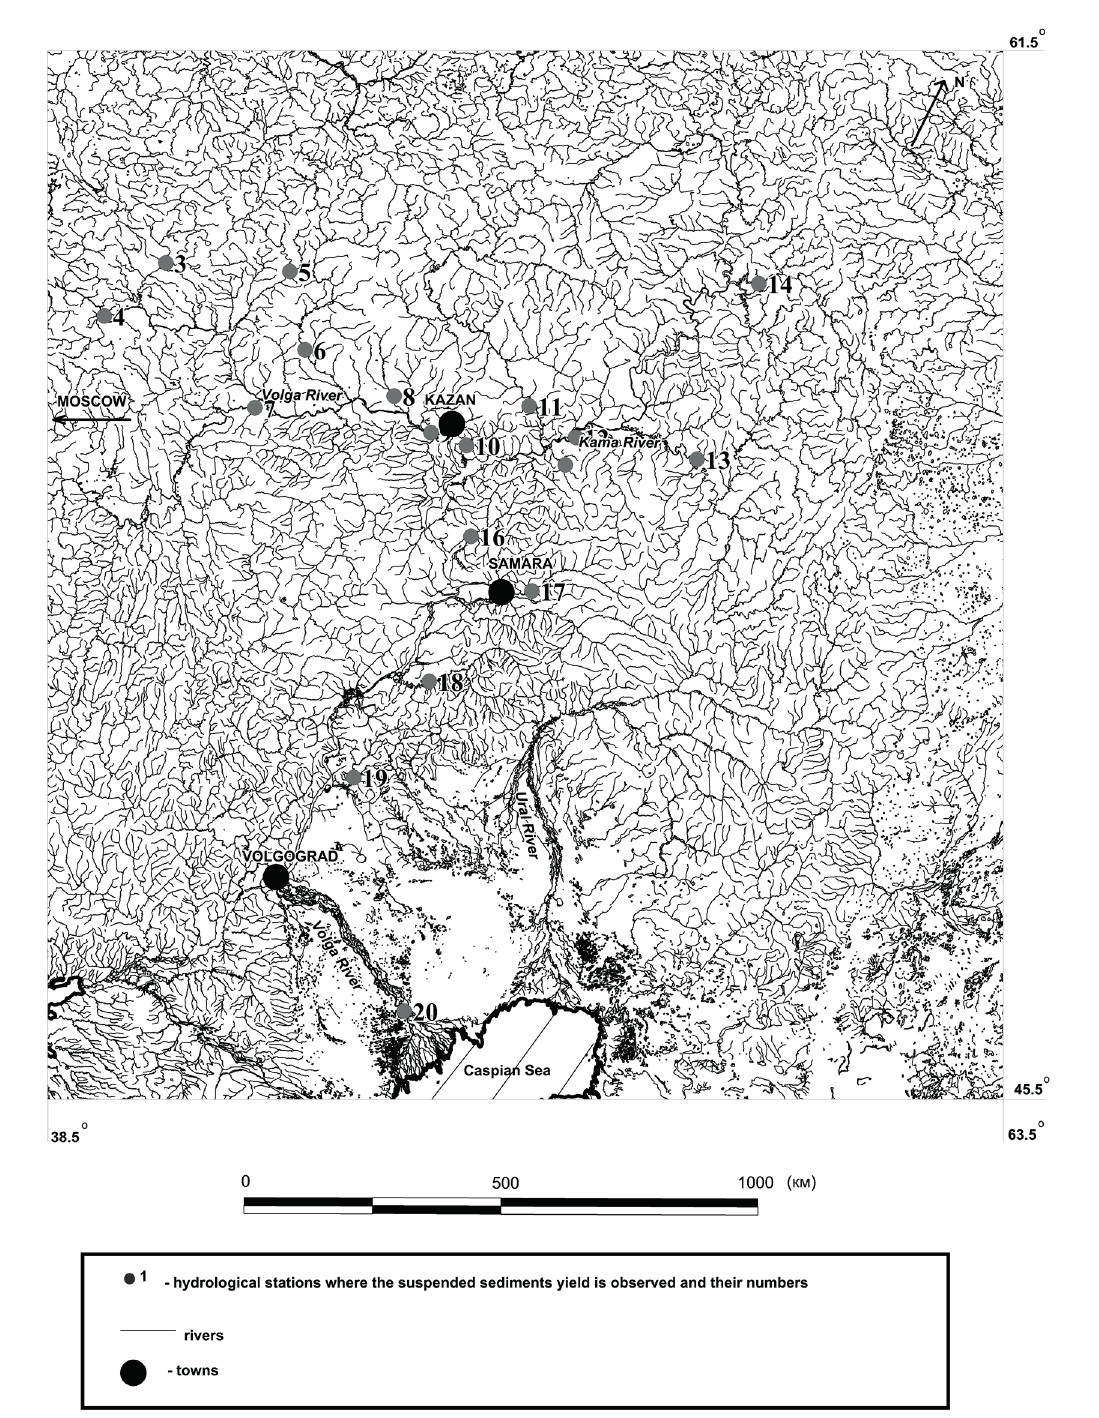
Fig. 2 Location of some hydrological measurement stations in the Volga River